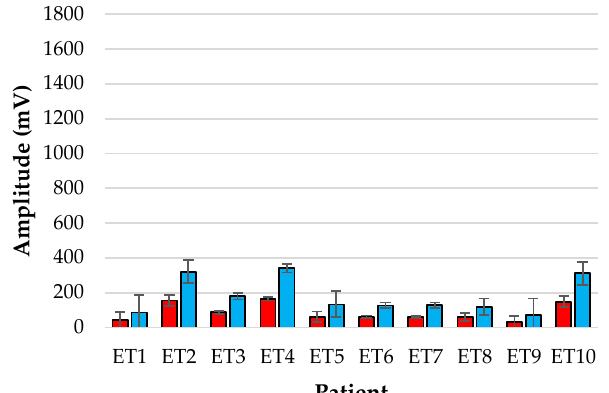
Figure 6. Amplitude analysis of normalised red (red) and infrared (blue) PPGs from the reference periphery sensor for each patient over the monitoring period.